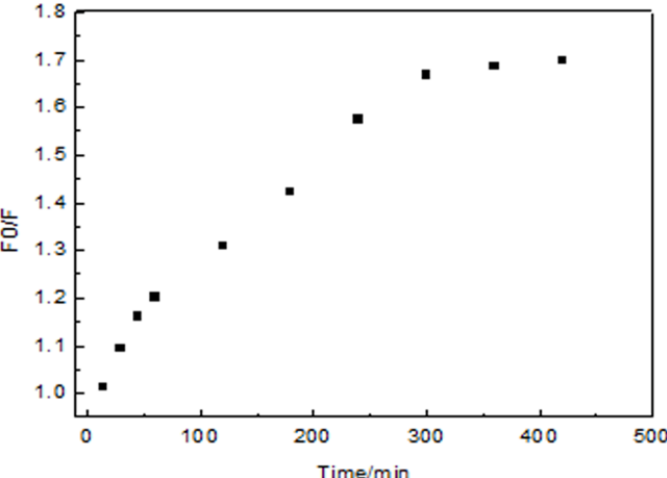
Figure 5. Recognition kinetics of Lys on the